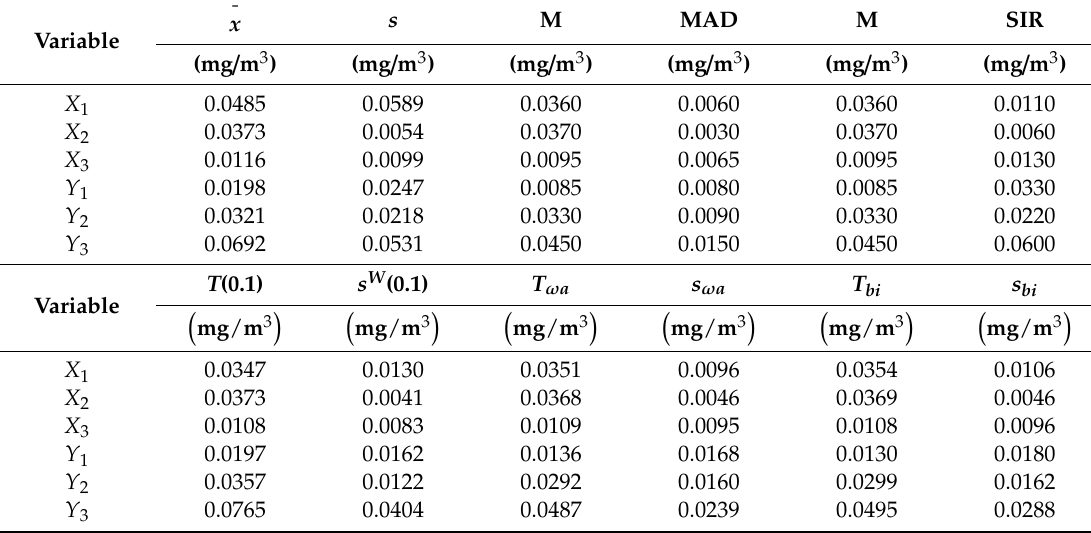
Table 1. The robust location and scale